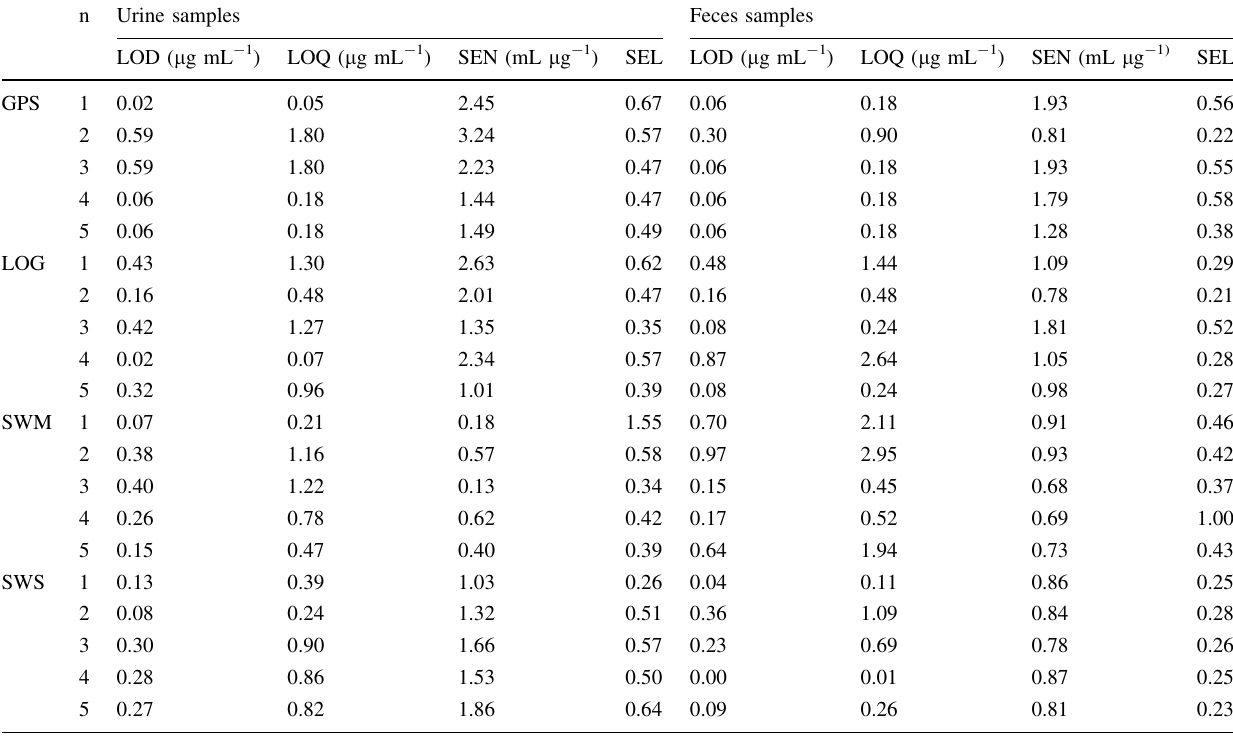
Table 6 FOM of four analytes in urine and feces samples using ATLD algorithm